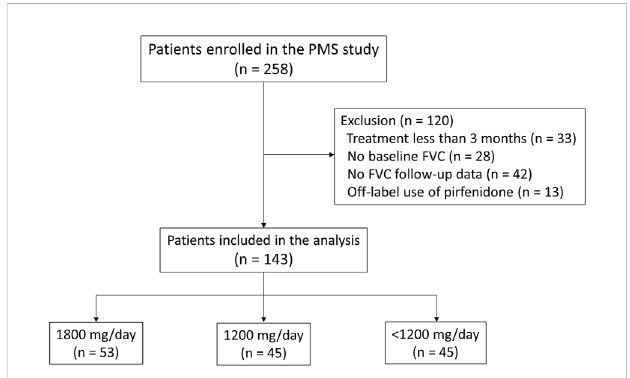
FIGURE 1 Study fl owchart Abbreviation: PMS, post-marketing surveillance; FVC, forced vital